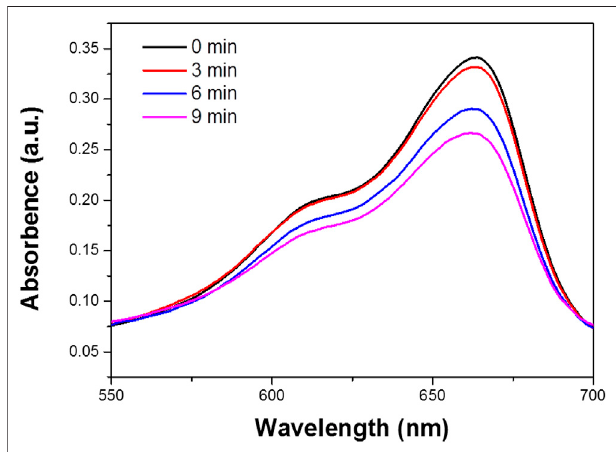
FIGURE6| ThemechanismforthedegradationofRBinthepresenceof the Bi 2 S 3 NPs under NIR laser.